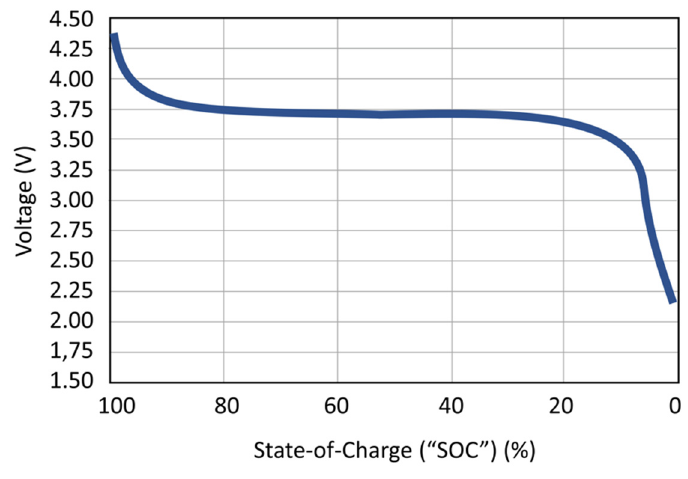
Figure 5. Typical Li ‐ ion discharge curve [25].